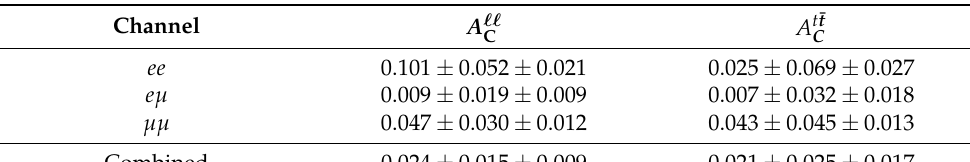
Table 1. Results for the lepton-based asymmetry A (cid:96)(cid:96) detector, resolution, and acceptance effects. The values in the ee , e µ , and µµ channels as well as the combined value are presented with their statistical and systematic uncertainties [20].